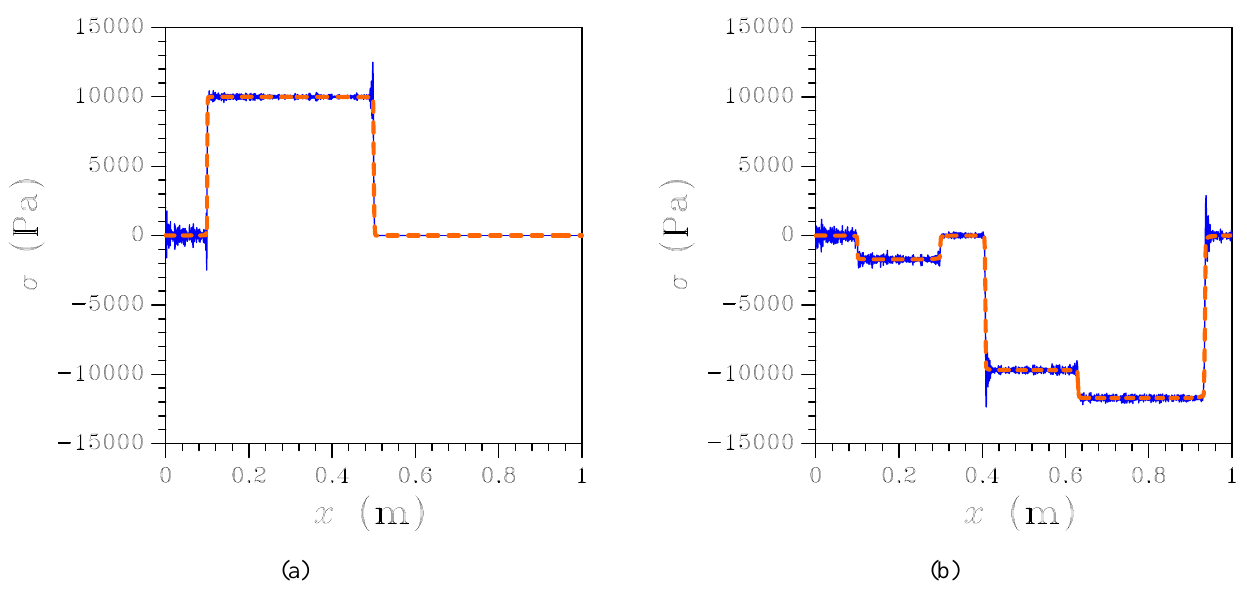
Figure 10. Wave propagating along a heterogeneous rod with perfect bonding between phases, discretized with an unstructured mesh: stress field at (a) t = 0 . 5 · 10 − 2 s and at (b) t = 1 . 3 · 10 − 2 s. Blue solid line: FE solution; orange dashed line: newly proposed FE-FCT